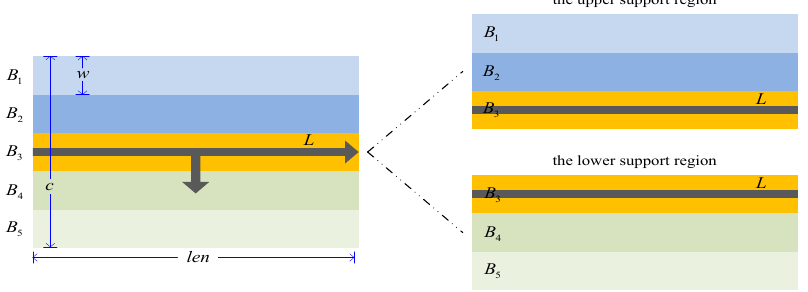
Figure 6. Construction of the line support region. The support region of line L has size c × len , and is divided into 5 bands, each of width w . The upper and lower support regions contain the first three bands and the last three bands, respectively, for the construction of descriptors on each side of the